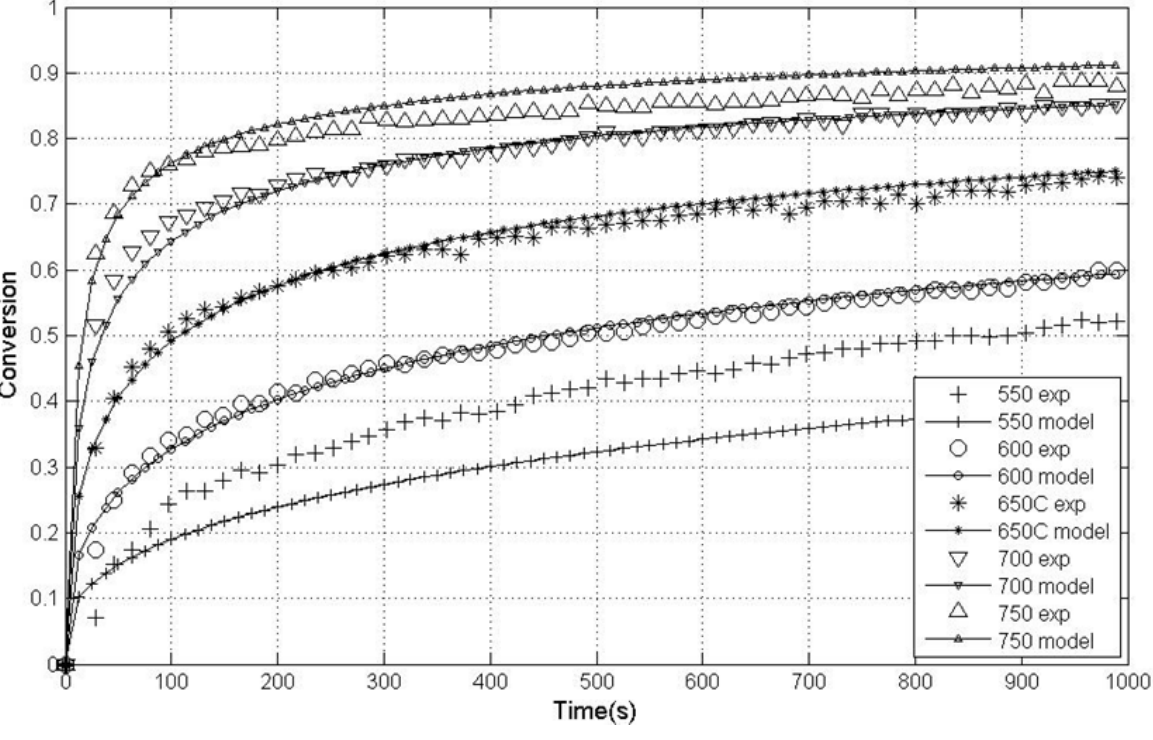
Figure 5. Validation of the model prediction against the experimental